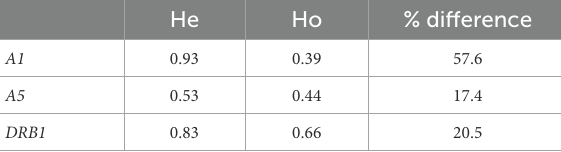
TABLE 2 Expected versus observed MHC